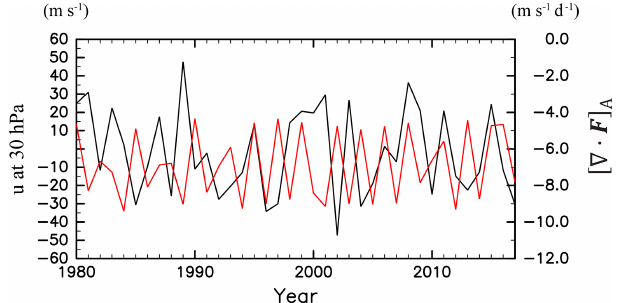
Figure 8. Time series of the JJA mean u at the Equator, 30hPa (red, m 2 s − 1 ) and [∇ · F ] A (black, ms − 1 d − 1 ) for